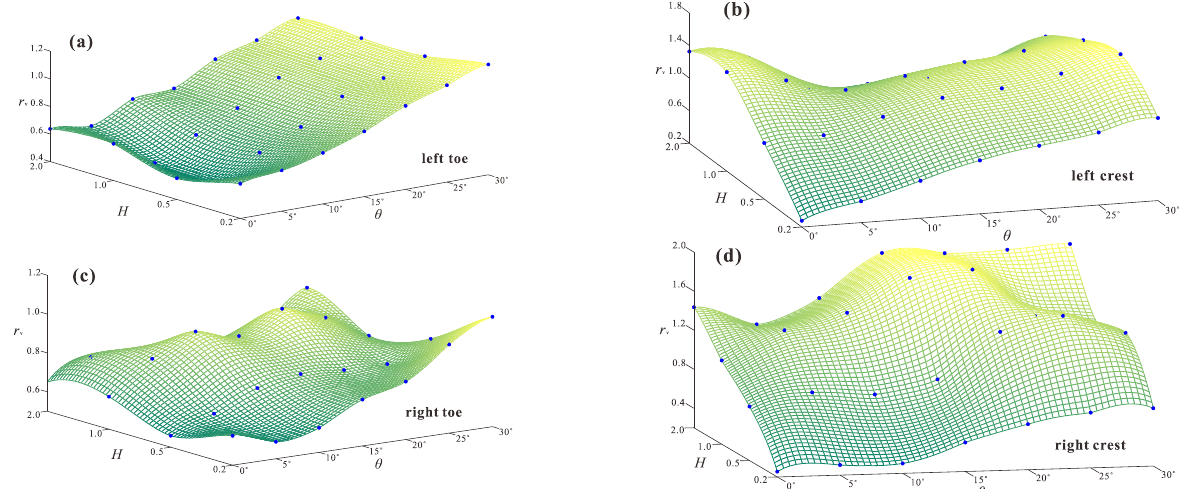
Figure 20. Variations of the vertical amplification ratios ( r v ) of PGA at the observation points (( a ) left toe, ( b ) left crest, ( c ) right toe and ( d ) right crest) with varied angles of wave incidence at different slope heights.